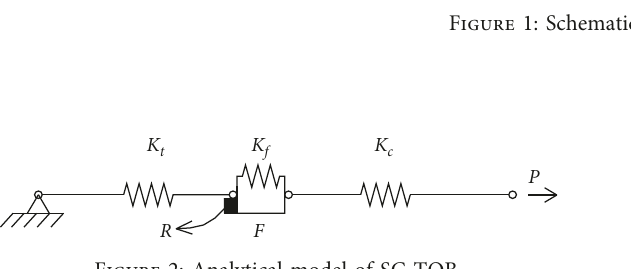
Figure 2: Analytical model of SC-TOB.